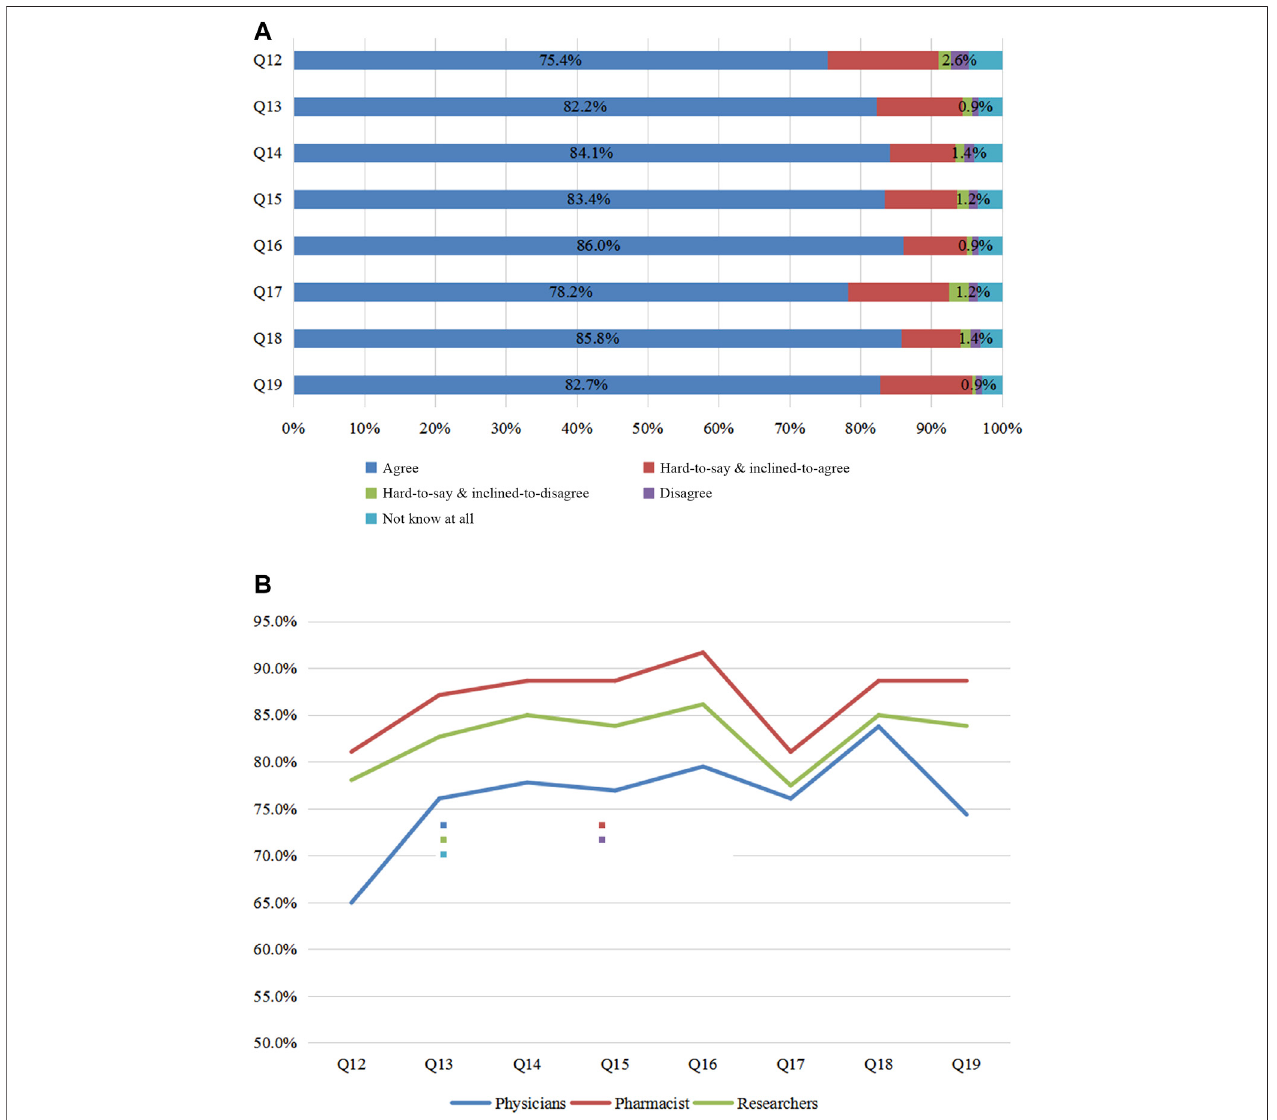
FIGURE 4 | Survey of promoting the application of PGx. Figure 4A : Views of all participants on Q 12 – 19. Figure 4B : Questions 12 – 19 were considered by physicians,pharmacists,andresearchers.Q12Inyouropinion,shouldthegovernmentformulatetherelevantregulationsforPGxDNAdetection?Q13Inyouropinion,is itnecessarytoformulatetherelevantguidelineofindividualizedPGxtherapyforChinesepopulations?Q14Inyouropinion,isitnecessarytoformulatethesectorcodesof PGxDNAdetection?Q15Inyouropinion,isitnecessarytoformulatethepricingcriteriaforPGxDNAdetection?Q16Inyouropinion,isitnecessarytoformulatethe reporting standardization of PGx DNA detection? Q17 In your opinion, should PGx DNA detection be included into National Medical Insurance Scheme? Q18 In your opinion, is it necessary to establish the PGx knowledge database for Chinese populations? Q19 In your opinion, should PGx courses be offered at colleges?